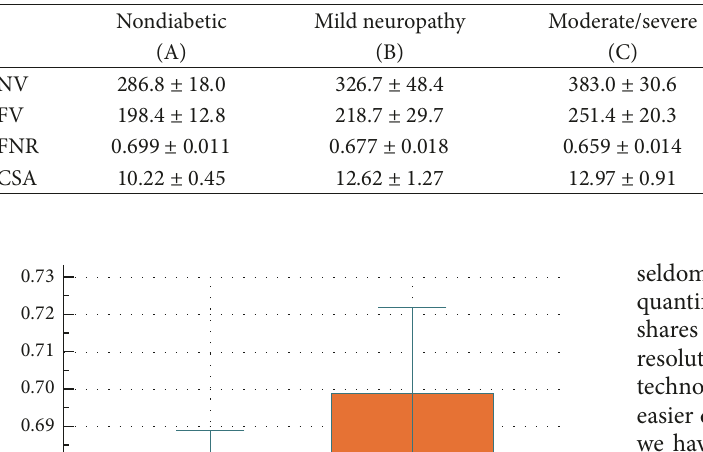
Table 3: Test between the control group and the two subgroups of diabetic neuropathy. All data are expressed in mean ± SEM. All patients included in the diabetic neuropathy group had abnormal nerve conduction studies. Subjects with a neuropathy disability score of less than 6 pointswereconsidered“mildneuropathy,”andsubjectswith6pointsormorewereconsidered“moderate/severeneuropathy.”Boldcharacters are used to enhance statistical significance. N.S. = Nonsignificant.